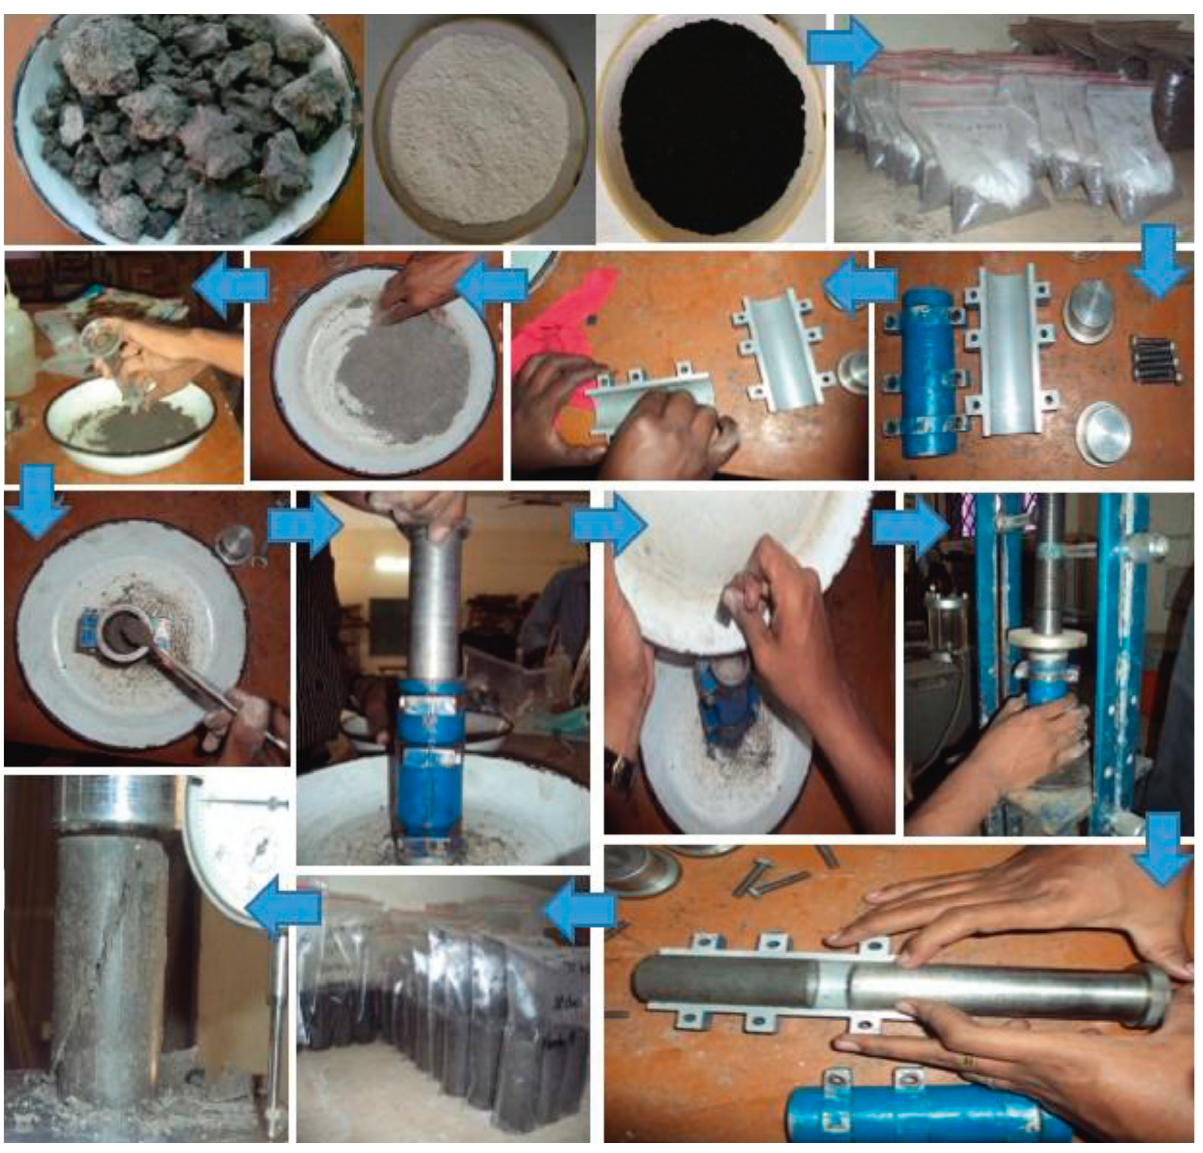
Figure 4: Preparation of UCS